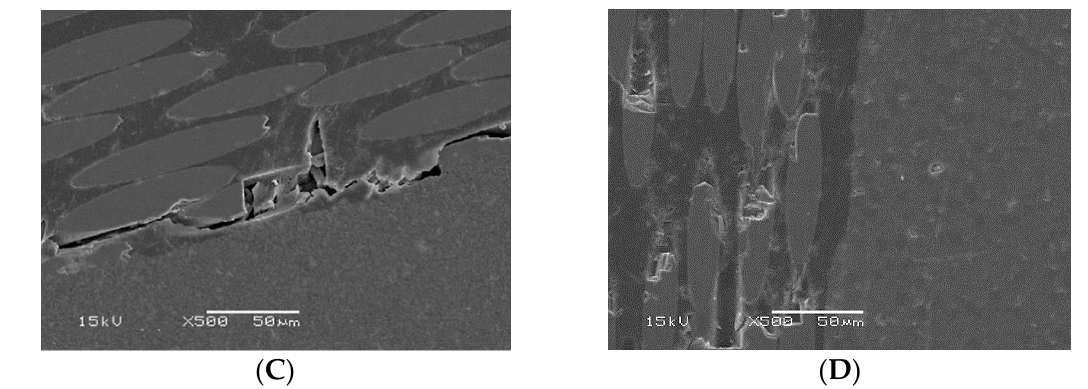
Figure 5. SEM images (×500 and 1000 magnification) of the adhesive interface (arrows) between fiber post and luting materials. ( A ): fiber post with Gradia Core before loading test, ( B ): fiber post with SFRC before loading test, ( C ): fiber post with Gradia Core after loading test (cracked), ( D ): fiber post with SFRC after loading test.